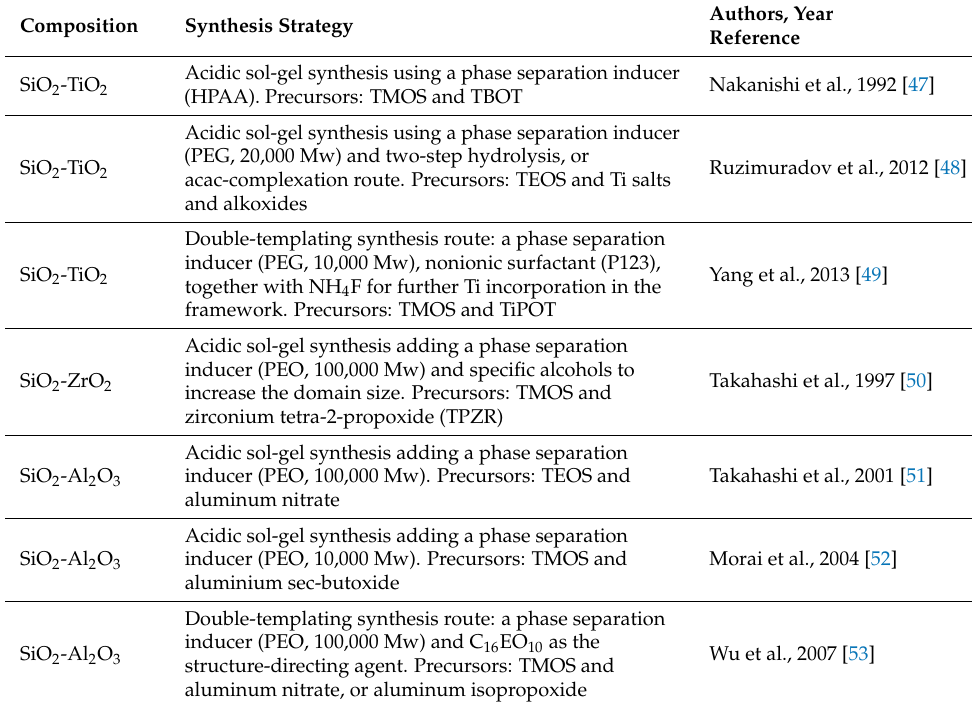
Table 2 compiles different synthesis strategies, based on co-gelation, for a variety of binary and other multicomponent oxide silica-containing hierarchically porous monoliths. Table 2. Varied synthesis strategies for the achievement of SiO 2 -based multicomponent oxide monoliths, prepared via sol-gel/phase separation